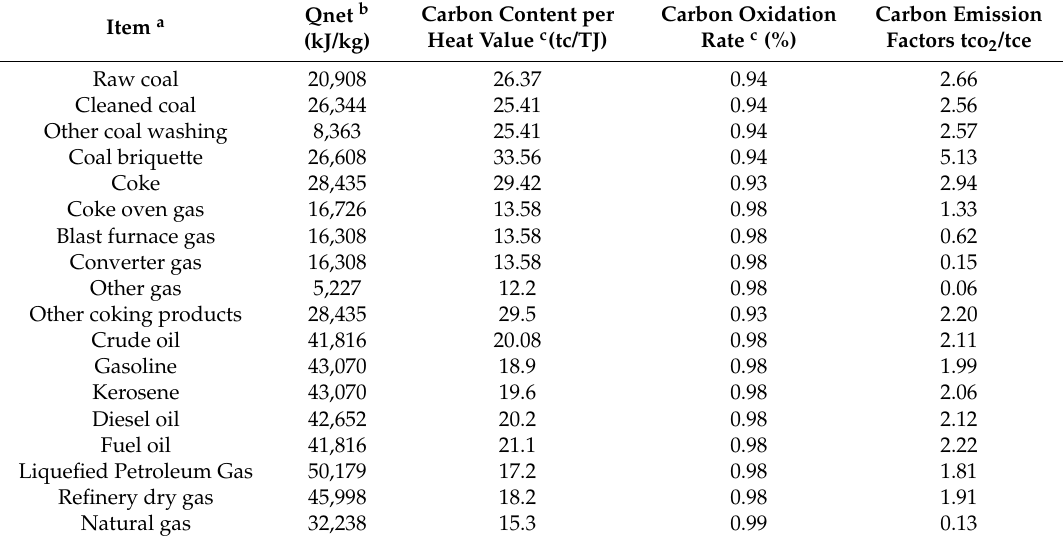
Table 3. The carbon emission factors calculated for the LEAP-Hebei